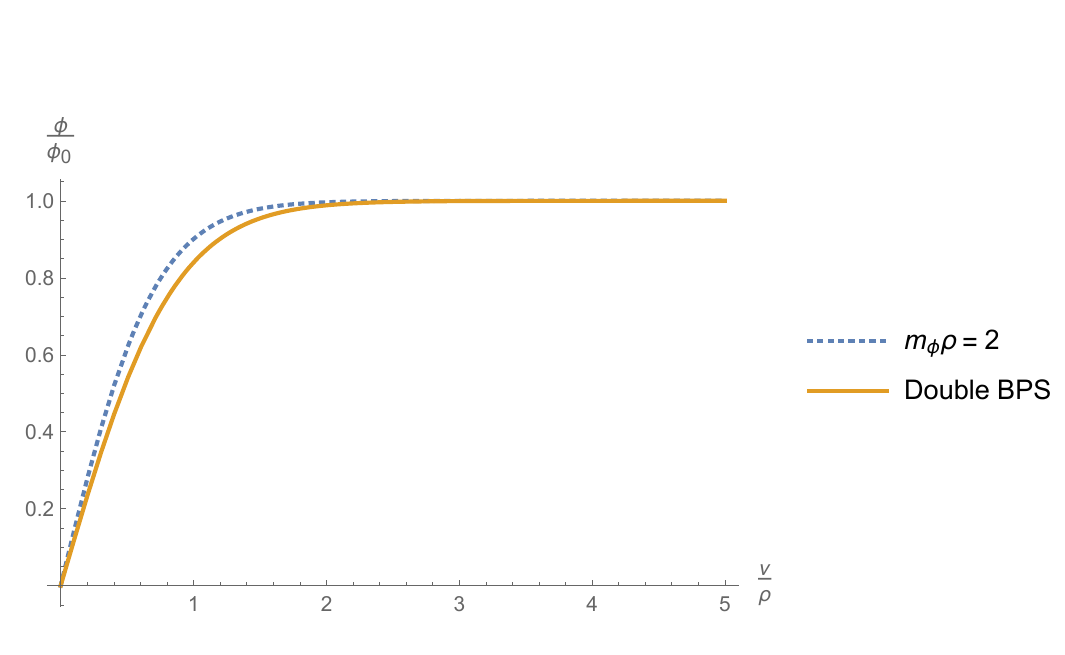
Figure 16 . Numerical solution for the ’t Hooft-Polyakov monopole ( q; l ) = (1 ; 3) in anti de Sitter space in the m A 0 limit with the Higgs (cid:12)eld Compton wavelength 1 =m (cid:30) = (cid:26)= 2. The solution # is compared to the exact double BPS monopole solution. The initial derivative of the numerical solution is (cid:30) 0 (0) = 1 : 424467087.